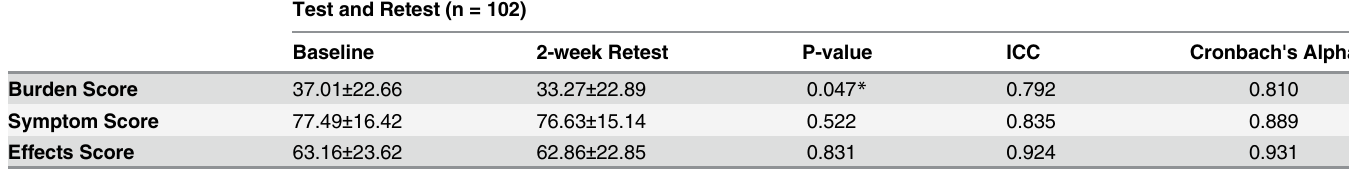
Table 6. Reliability of disease specific domains of